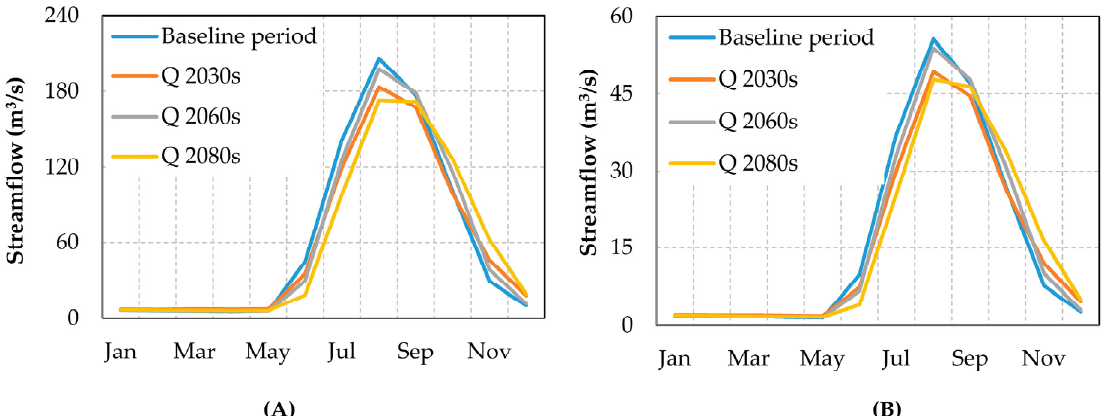
Figure 11. Average monthly streamflow for the baseline period and for the projected time horizon for: ( A ) Main Beles; and ( B ) Gilgel Beles.